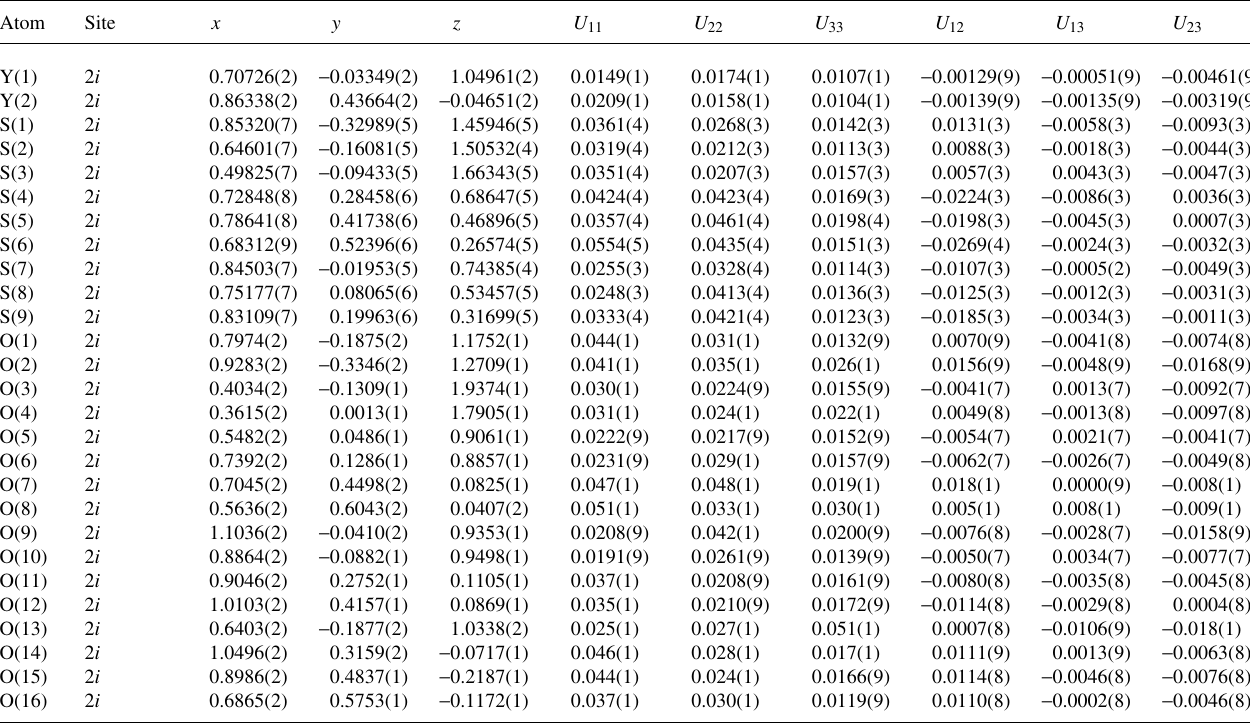
Table 3. Atomic coordinates and displacement parameters (in Å 2 ) .